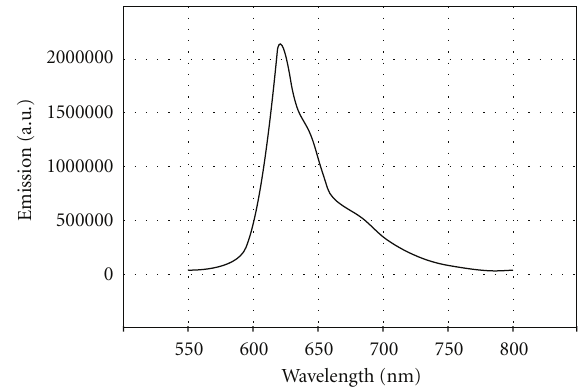
Figure 5: Prompt fluorescence spectrum of CV in ethanol.